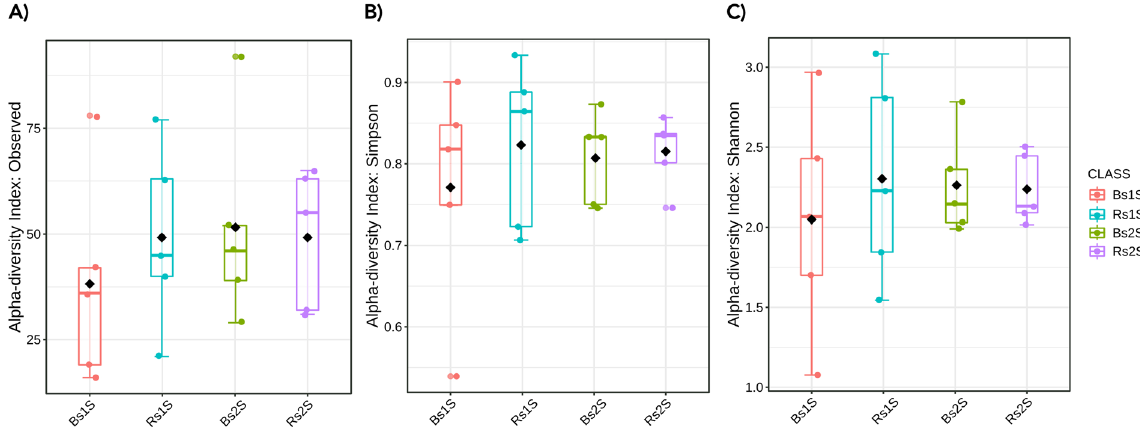
Figure 3. Alpha diversity indices. A) Number of observed AMF species (p-value 0.7073), B) Simpson index (p-value 0.94376) and C) Shannon’s Index (p-value 0.92697) of biodiversity detected in Bulk soil (Bs) and in soil associated with the roots of V. vinifera cv. Pinot Noir (Rs) at the two sampling times (1 S = flowering and 2 S = fruit development). Alpha diversity analysis was performed using the phyloseq package of MicrobiomeAnalyst, a free available on-line software